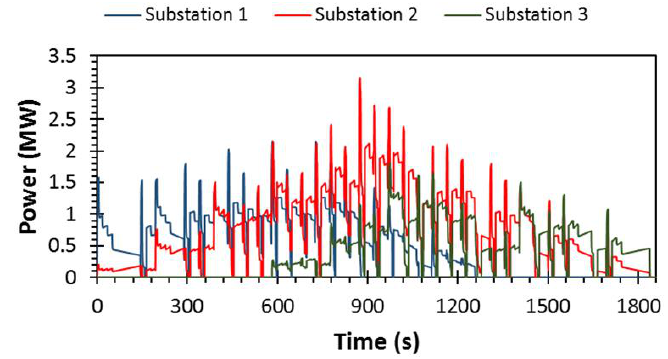
Figure 14. The substations’ power of a single railway track.